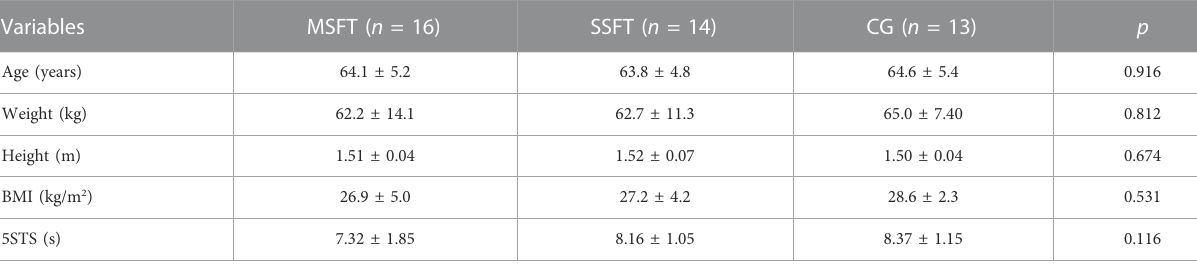
(Figure 3E): pre vs. post-24, p = 0.0326, ES: 0.91; and SSFT post-24 vs. CG post-24, p = 0.0158, ES: 0.80).